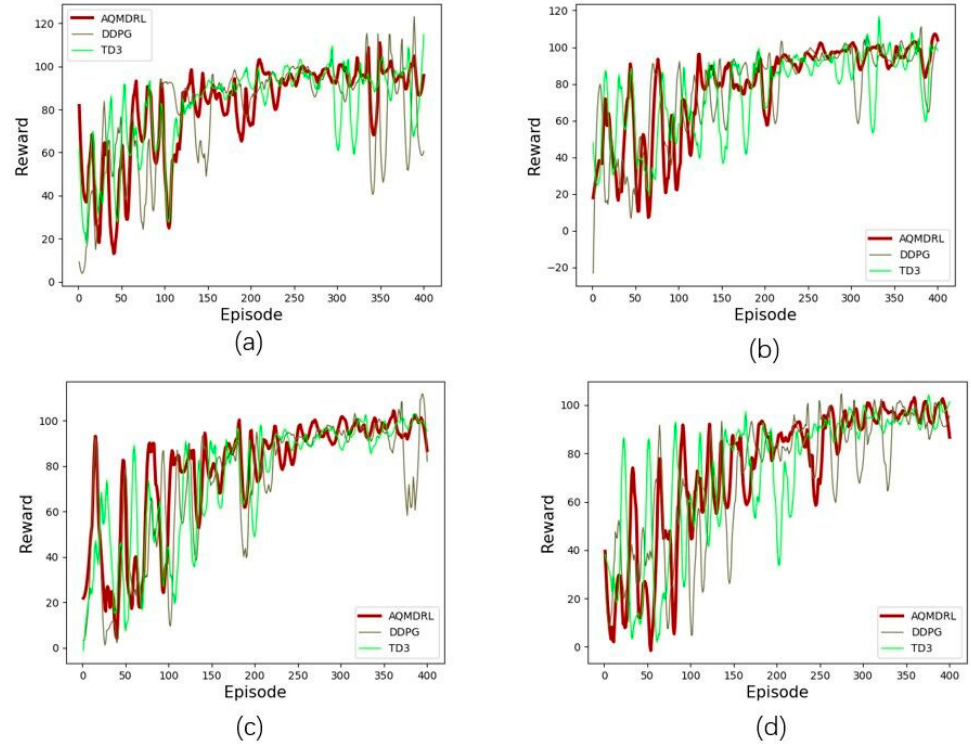
Figure 5. Algorithm performance comparison: ( a ) the traffic intensity is 100%; ( b ) the traffic intensity is 75%; ( c ) the traffic intensity is 50%; ( d ) the traffic intensity is 25%. Link delay and load balancing are significant for the quality of service in the network.